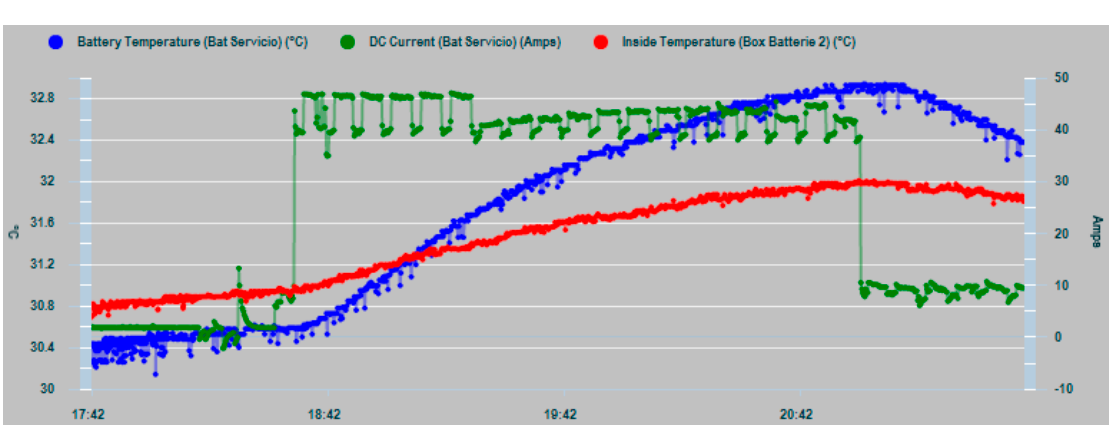
Figure 26. Test for divergent comparative trend analysis of T in (blue) and T amb (red), where the heat dissipation capacity is being exceeded prior to dry out and eventually to thermal runaway failures.